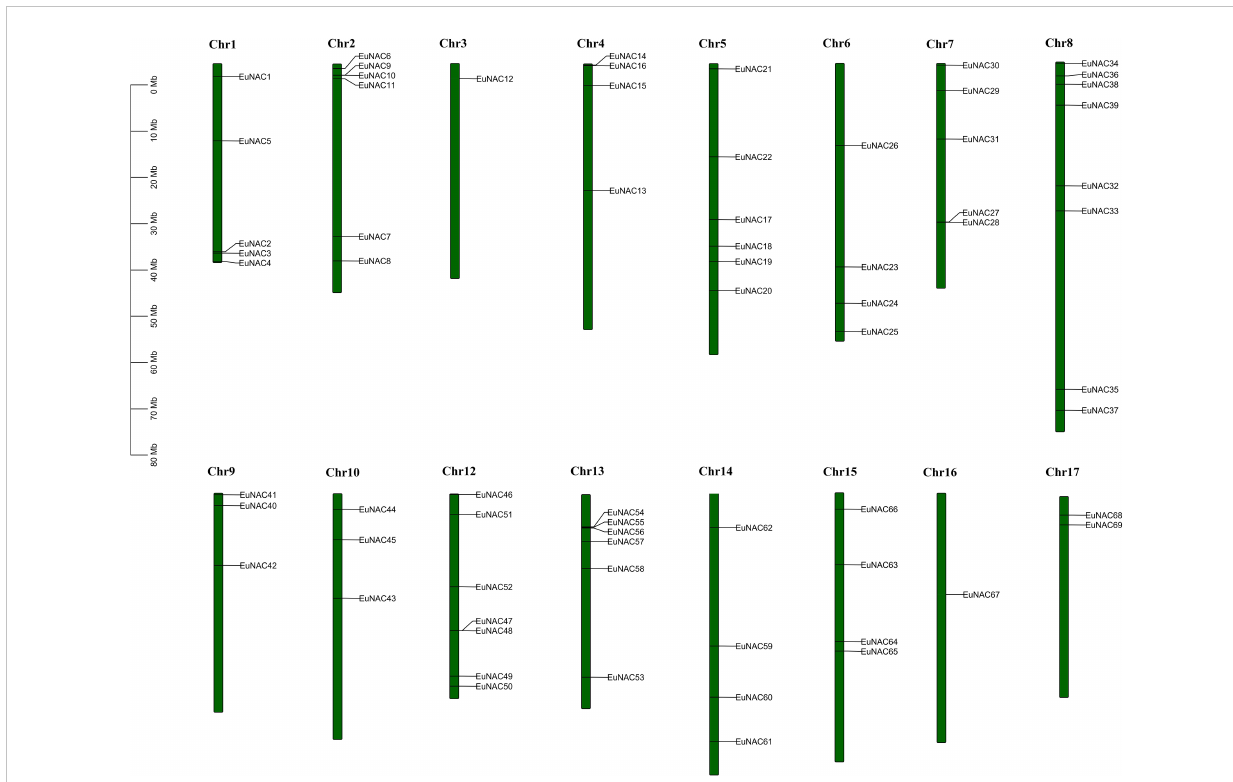
FIGURE 4 Gene Location on chromosome of E. ulmoides . Vertical bars represent the chromosomes of E. ulmoides . The chromosome number is to the up of each chromosome. The scale on the left represents chromosome